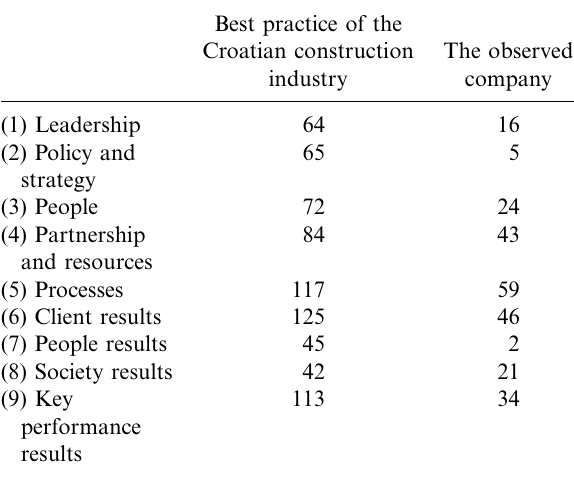
Table 2. Comparison between best practice and the observed company